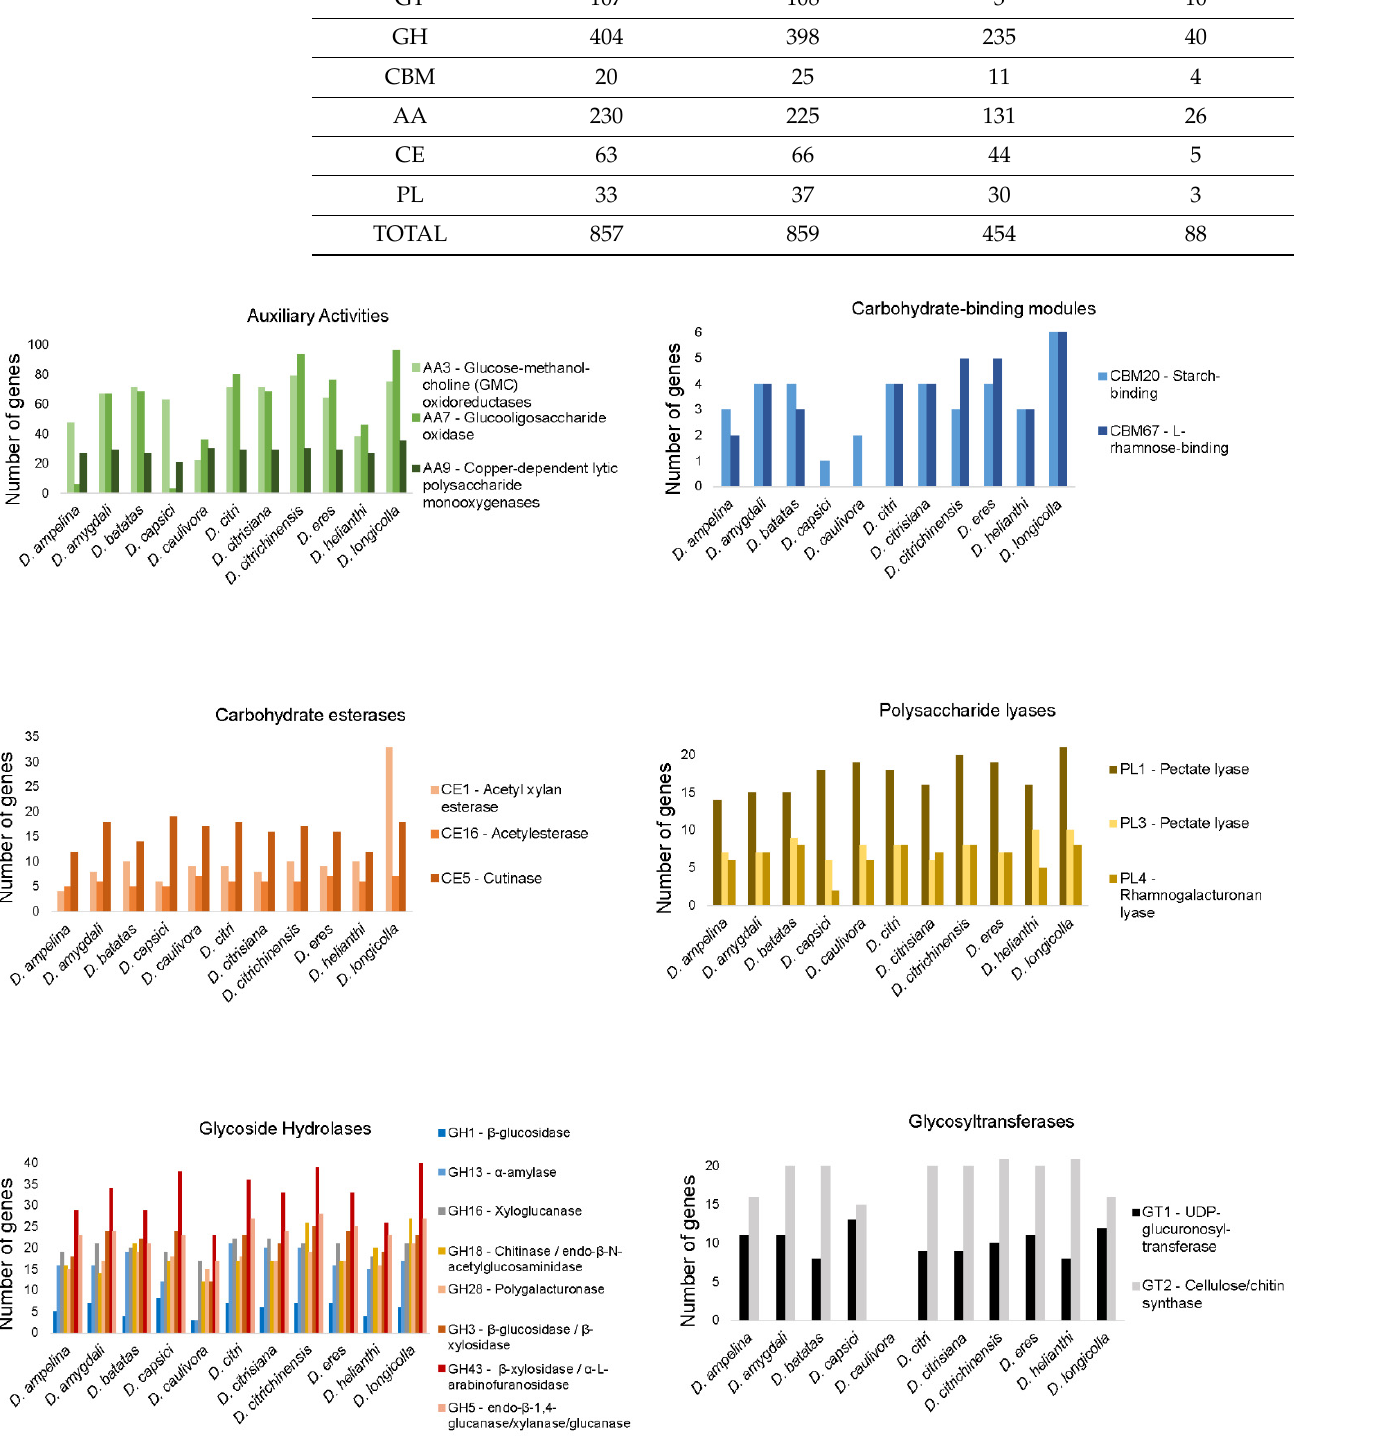
Figure 3 . Number of predicted genes encoding for the most abundant carbohydrate-active enzyme families in all genomes of the analyzed Diaporthe species.